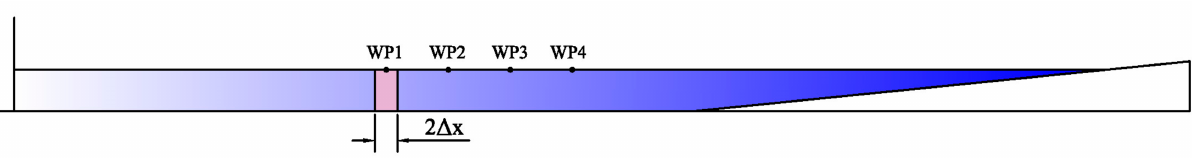
Figure 18. Construction of the strip for calculation of energies of the particles. The length of the strip has been exaggerated to aid in